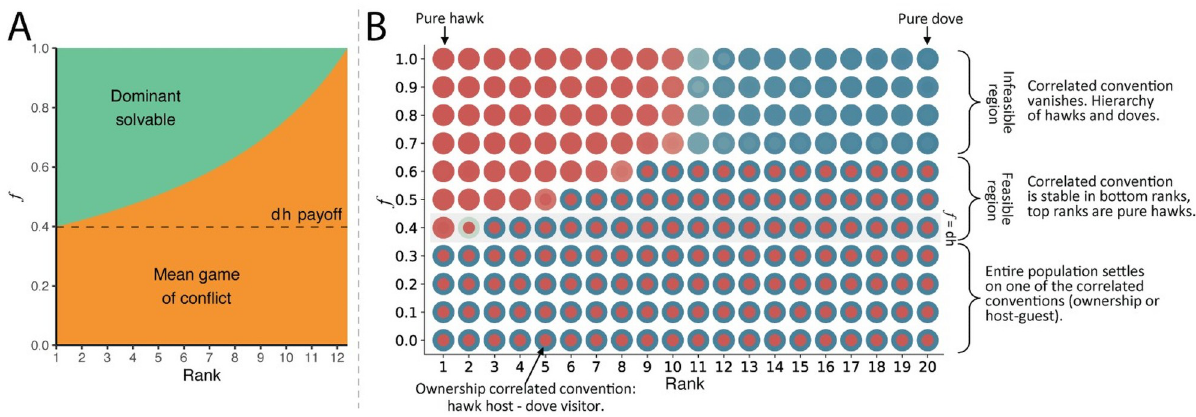
Fig 2. In games of conflict with power asymmetry and random interaction, individuals with different ranks effectively face different games. A , Analytical analysis of our model reveals that, under random interaction, individuals play different games, depending on their rank and the degree of the power asymmetry f (see S1 Text). For f < dh , power asymmetry has no effect and individuals of all ranks engage in a mean game of conflict (the orange area). For f � dh , the game is dominant-solvable for the top ranked individual(s). B , Numerical results from evolutionary simulations show that conventions prevail when f is below the critical value dh ; individuals of all ranks play correlated conventions (either all ownership or host-guest; each appear with equal frequency in simulation seeds; ownership shown). At f � dh a transition occurs as ranking individuals break from the convention and adopt pure hawk behavior both home and away. The correlated convention is resilient among most individuals until high values of f make it unsustainable. A hierarchy forms in which the top-half of individuals are pure hawks while the bottom-half are pure doves . Note how the analytic result on the left matches the numeric result on the right. (Both panels use n = 20; dh = 0.4; dd = 0.6).